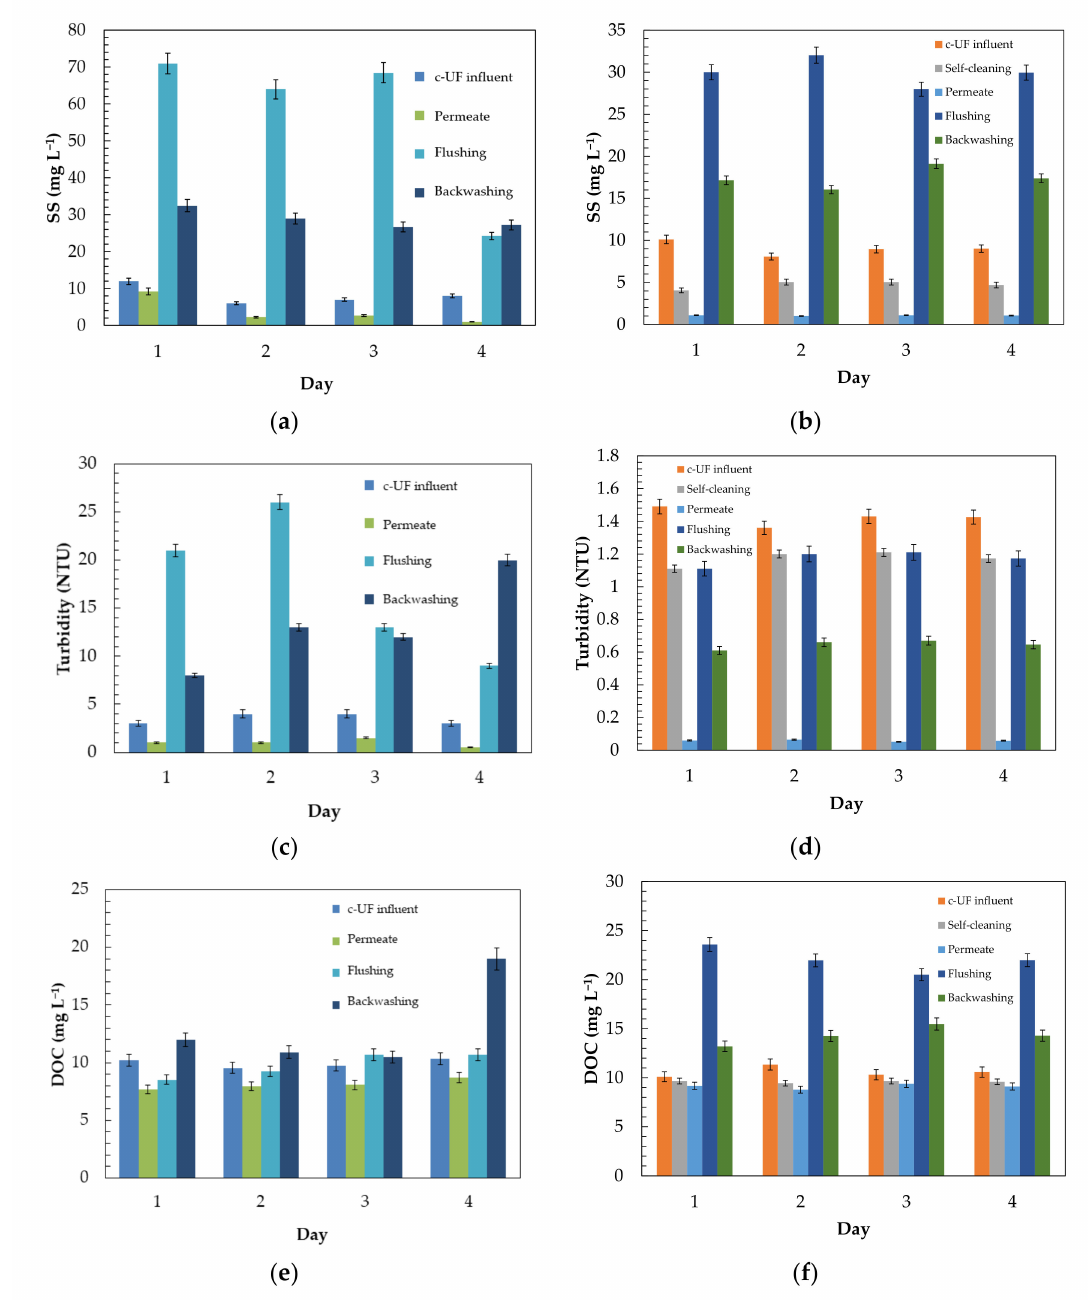
Figure 3. Comparison of the traditional c-UF system and self-cleaning c-UF on an effluent from the secondary treatment. Evaluation of macroscopic parameters of water quality: ( a ) suspended solids (SS); ( c ) turbidity; and ( e ) dissolved organic carbon (DOC); ( b , d , f ) with self-cleaning